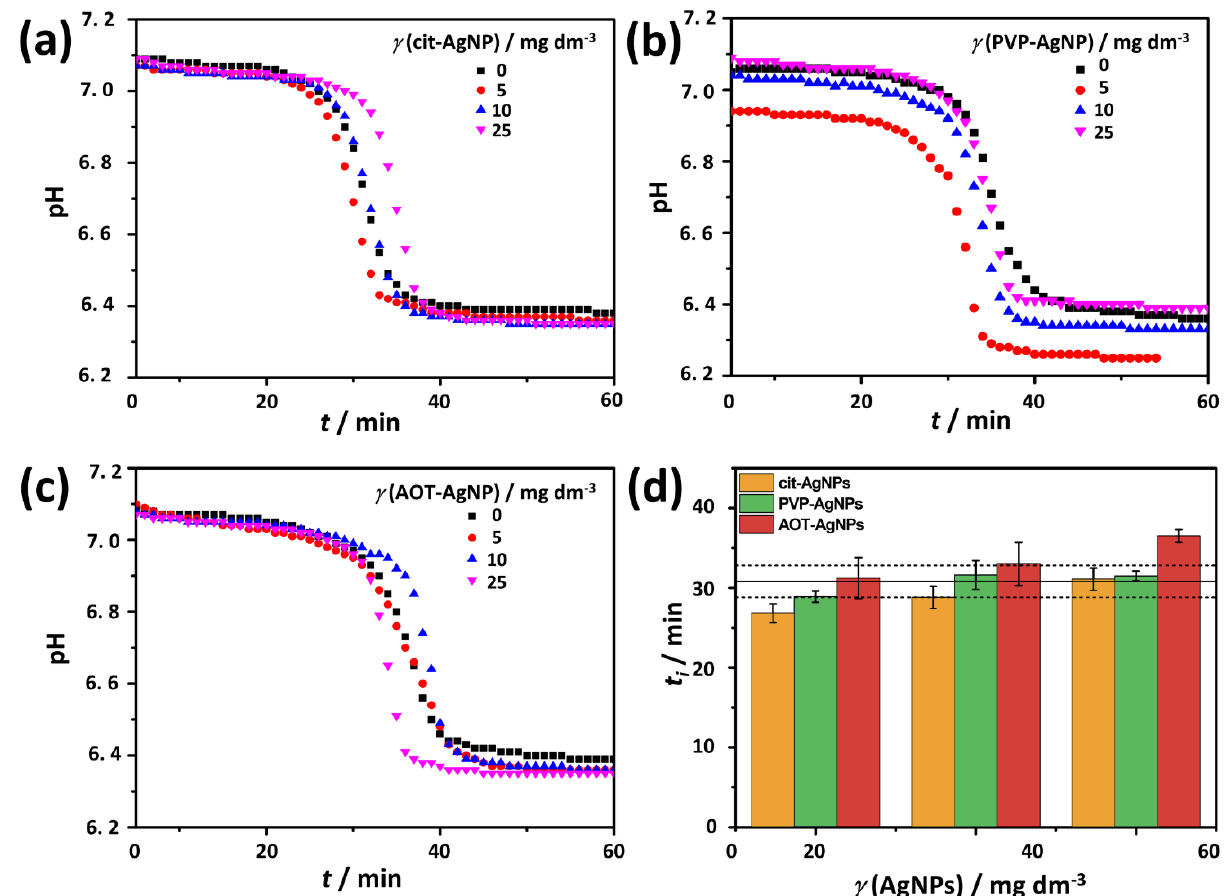
Figure 4. Representative pH vs. time curves ( a – c ) and corresponding average induction time for crystalline phase precipitation ( t i ) with corresponding standard deviation ( d ) obtained in the control system ( γ (AgNPs) = 0 mg dm − 3 ) and in the presence of different concentrations of silver nanoparticles (AgNPs) stabilized with ( a ) citrate (cit-AgNPs), ( b ) poly(vinylpyrrolidone) (PVP-AgNPs), and ( c ) sodium bis(2-ethylhexyl) sulfosuccinate (AOT-AgNPs). In figure ( d ) full and dashed lines represent the average induction time and corresponding standard deviation in the control system, respectively. c (CaCl 2 ) = c (Na 2 HPO 4 ) = 4 · 10 − 3 mol dm − 3 , pH 7.4, 25 ◦ C. To determine the influence of AgNPs on the properties of ACP, the precipitates formed after 10 min of reaction time were analyzed by PXRD, FTIR (Figure 5), and TEM (Figure 6). In the PXRD pattern of the precipitate, formed in the control system after 10 min, a broad amorphous peak of low intensity was observed at 2 θ 25.0 ◦ –33.5 ◦ (Figure 5). Such a peak is characteristic of ACP [27,63,64]. In the PXRD patterns obtained in the presence of different concentrations of AgNPs, the amorphous peak characteristic of ACP was observed only in the presence of the lowest concentration of cit-AgNPs, but not in the PXRD patterns of the precipitates formed in other systems with AgNPs, due to the high intensity of the peaks characteristic of silver observed at 2 θ 38.1 ◦ , 44.2 ◦ and 64.50 ◦ corresponding to the (111), (200) and (220) reflections of silver (ICCD File No 04-0783), respectively (Figure